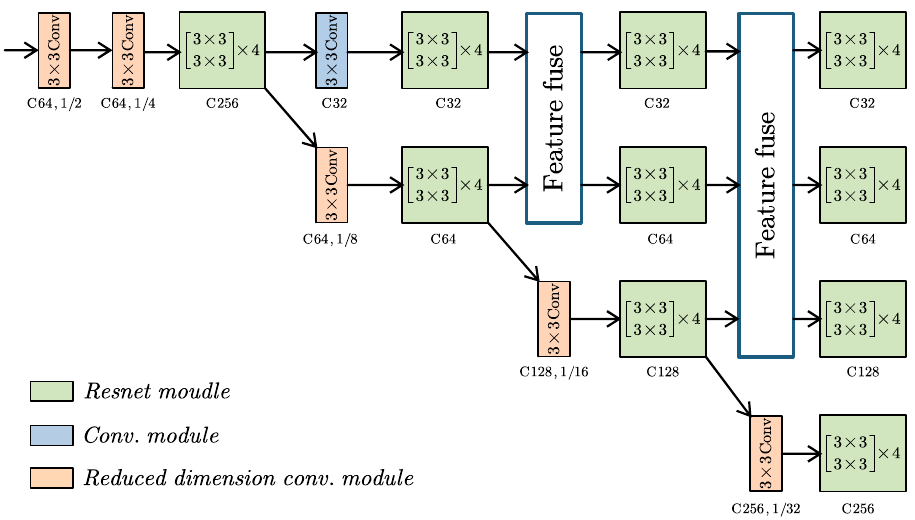
Figure 3. Feature extraction backbone network structure diagram.